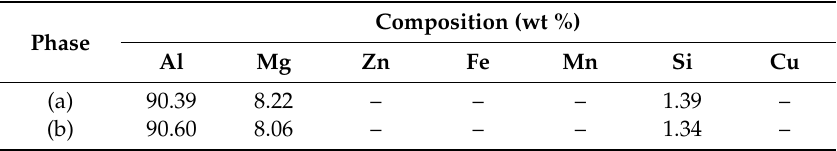
Figure 7. SEM-EDS secondary phase analysis after homogenization at: ( a ) 450 ◦ C, 24 h; ( b ) 450 ◦ C, 30 h. Table 4. Chemical composition of secondary phases in Figure 7 after homogenization.